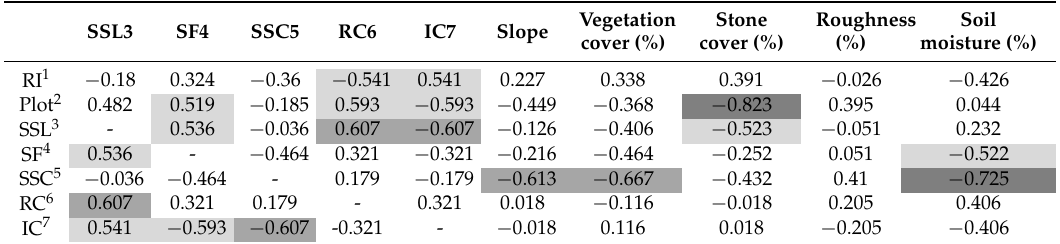
Table 4. Spearman correlation coefficient of the whole